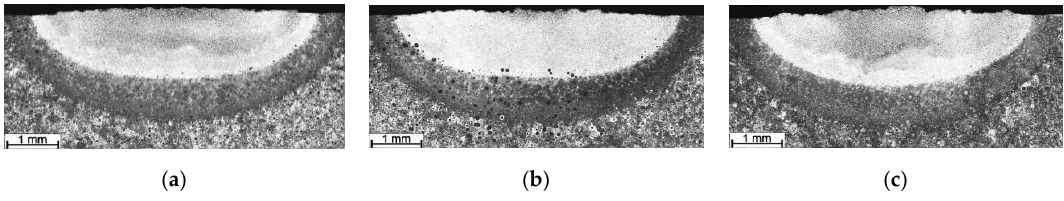
Figure 2. Optical macrographs of the SABs produced using a powder mixture of 80Ti-20Mo (weight ratio); SAB no. (Table 2): ( a ) TM1, ( b ) TM2, ( c ) TM3.